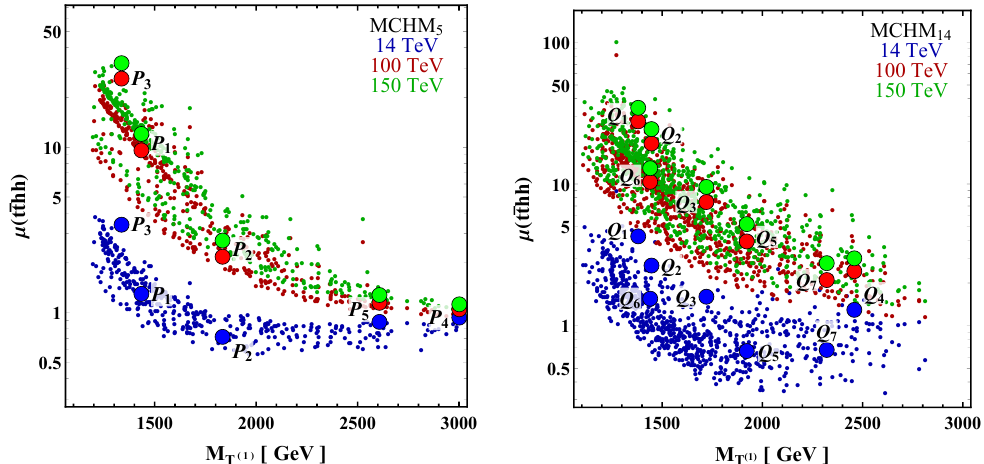
Figure 8 . Normalized tthh cross section as a function of the lightest Q = 2 / 3 vector-like mass, for 14, 100 and 150 TeV CM energies. The upper (lower) plots correspond to the MCHM 5 (MCHM 14